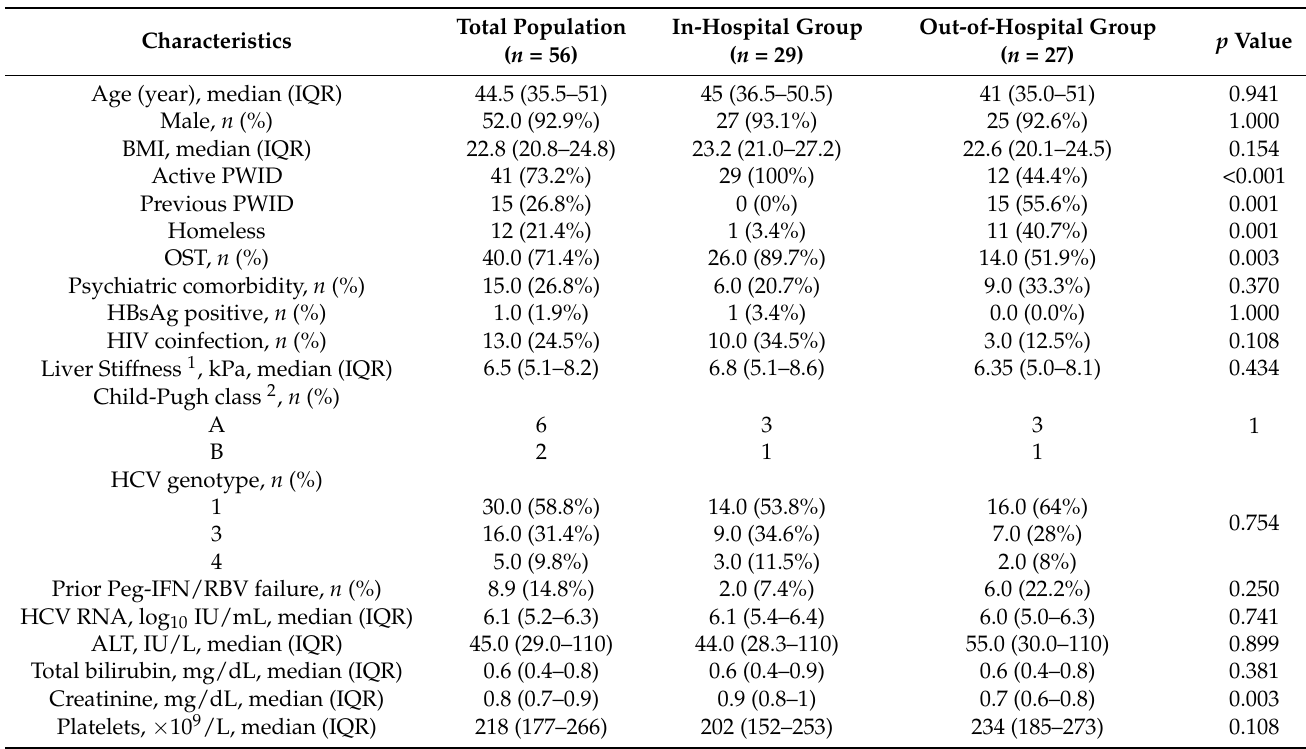
1 assessed by transient elastography (FibroScan ® ), 2 variable described only for those patients with documented diagnosis of liver cirrhosis ( n = 8). Abbreviations: BMI, body mass index; PWID, people who inject drugs; OST, opioid substitute therapy; IFN, interferon; RBV,